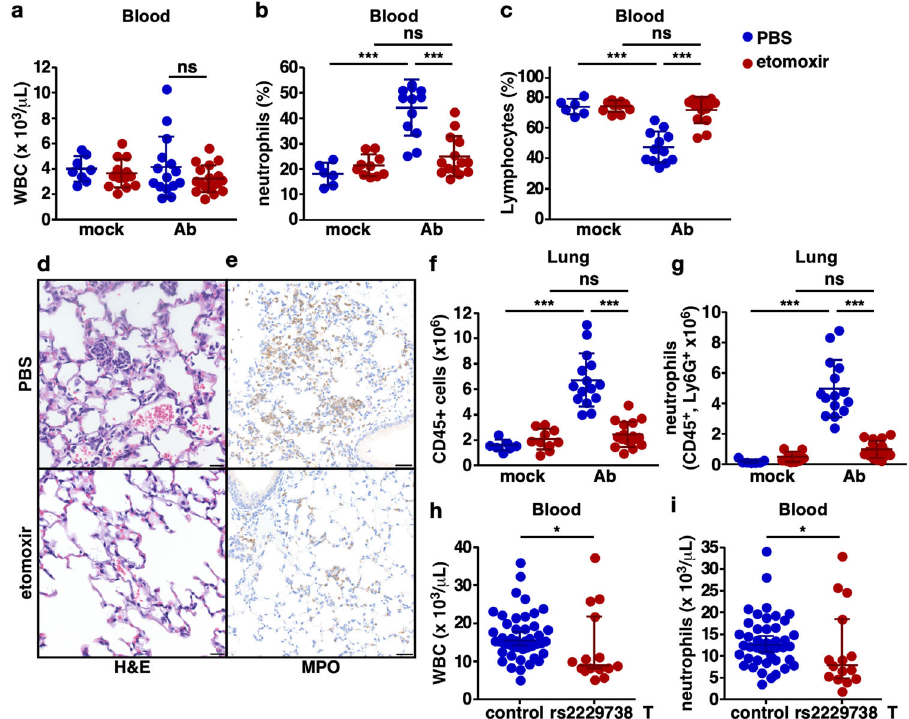
Fig. 3 Pharmacologic Cpt1a inhibition reduces neutrophil recruitment to the site of infection. Mice were treated with the Cpt1a inhibitor, etomoxir, or PBS carrier and challenged intranasally with A. baumannii or mock-infected with intranasal instillation of PBS, and blood and lungs were examined at 12 h. Complete blood counts were performed and total WBC count ( a ), percentage of neutrophils ( b ), and lymphocytes ( c ) are shown. Sections of lung from etomoxir or PBS-treated A. baumannii -infected mice stained with hematoxylin and eosin ( d ) or immunohistochemical staining for myeloperoxidase ( e ) are shown. Scale bars indicate 30 μ m. Mouse lungs from A. baumannii -infected mice were processed for single-cell cytometric analysis following staining with a myeloid antibody panel, and the total number of CD45-positive cells ( f ) and neutrophils ( g ) are shown. Complete blood counts from patients carrying the Cpt1a rs2229738_T allele and control patients with clinical evidence of pneumonia were obtained and total WBC ( h ) and blood neutrophil counts ( i ) are depicted. Circles represent data from individual subjects, the horizontal line represents the mean, and error bars depict the standard deviation. Means were compared using a one-way ANOVA adjusted for multiple comparisons ( a – c , h , i ) or a Mann – Whitney test ( d , e ). WBC white blood cell, Ab A. baumannii ; * P < 0.05; *** P < 0.001; ns not signi fi